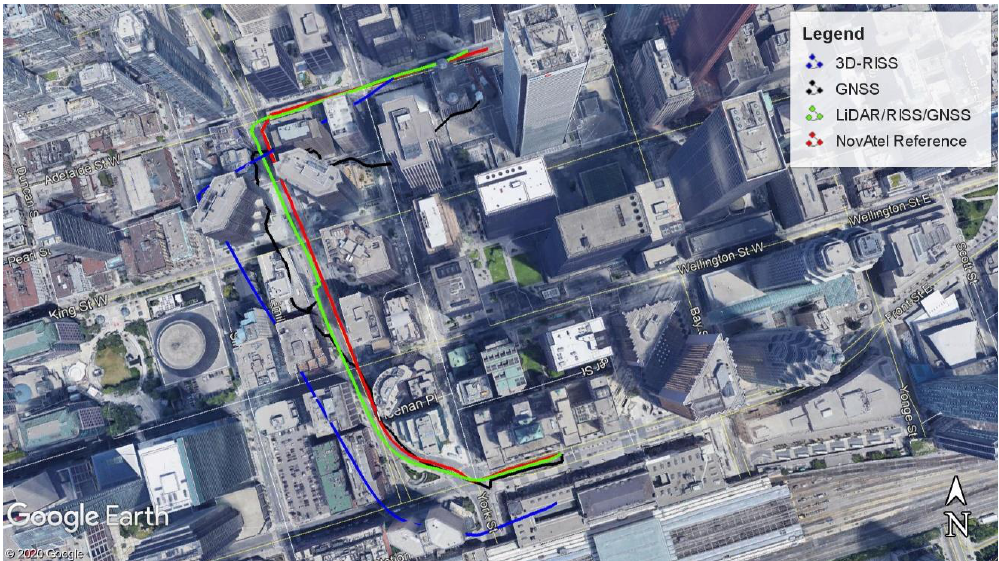
Figure 29. Navigation solution for 3D-RISS, GNSS, LiDAR/RISS/GNSS, and NovAtel reference during the Scenario (Third Switch).